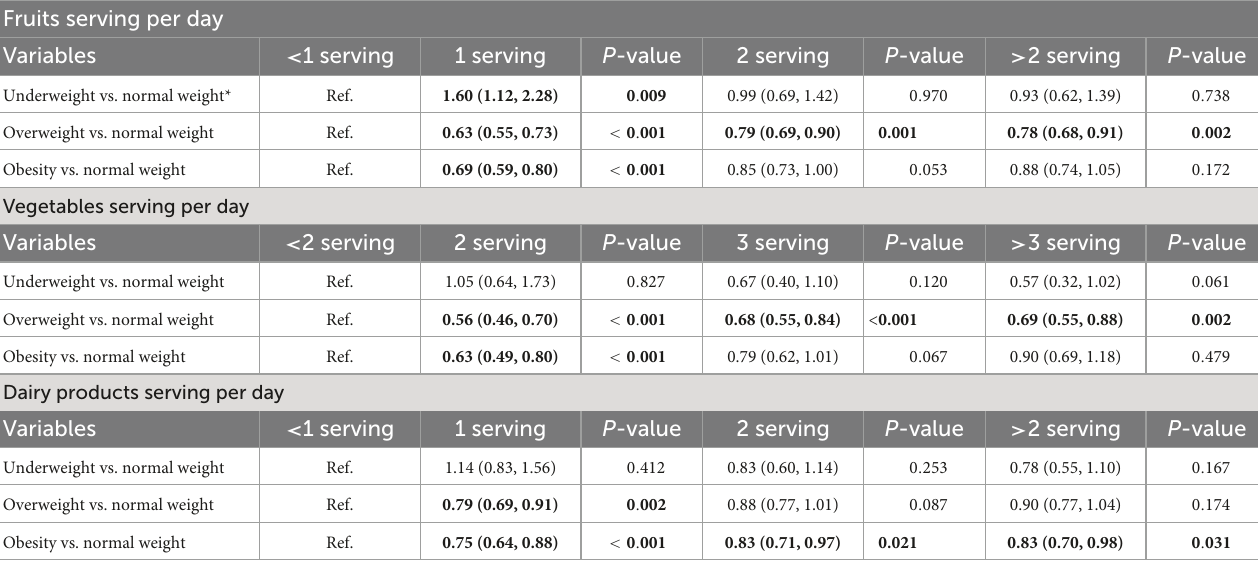
TABLE 2 Association between intake of fruits, vegetables and dairy products with body mass index (BMI) in the crude model. Fruits serving per day